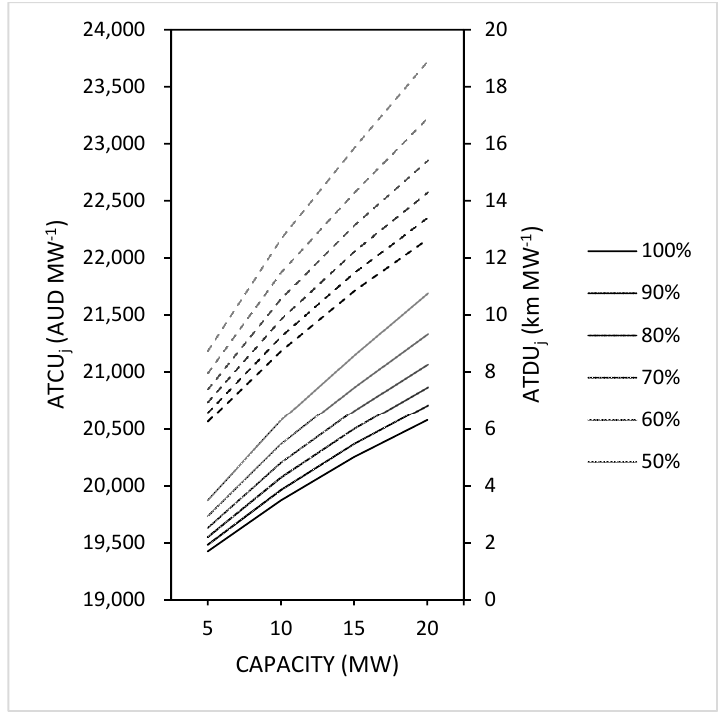
Figure 6. Sensitivity of mean ATCU j (solid line) and mean ATDU j (dotted line) of the ten best facilities to reduced biomass availability.